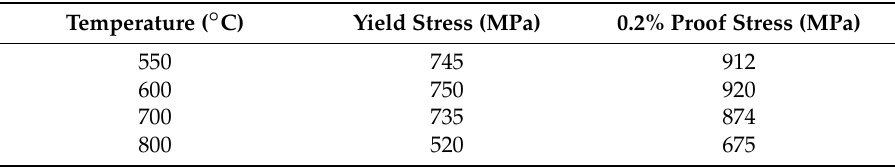
Figure 7. Deriving the constants for the Wilshire equations. Table 2. Yield stress values for Waspaloy.